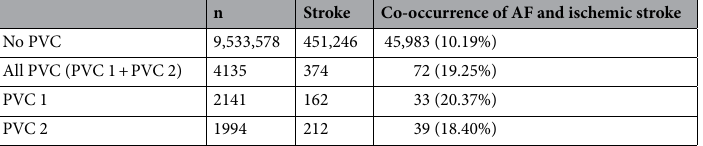
Table 3. New-onset AF and ischemic stroke. AF atrial fibrillation, PVC premature ventricular contraction.